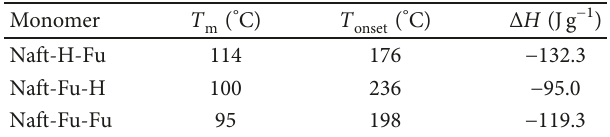
Table 1: Summary of the values of the nonisothermal DSC thermograms of the